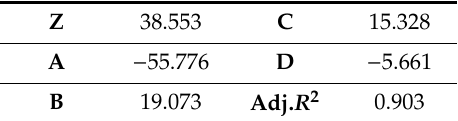
Table 4. Parameters Z, A, B, C, D and adjusted coe ffi cient of determination (Adj. R 2 ) for the fitting curve described by Equation (7).